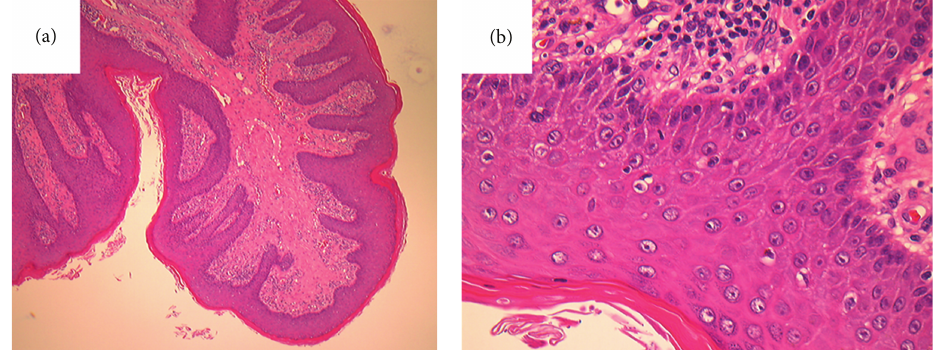
Figure 2: Fibroepithelial polyp covered by epidermis with hyperkeratosis leading to irregular epidermal projections and interstitial proliferation (hematoxylin-eosin staining: (a) × 40; (b) ×